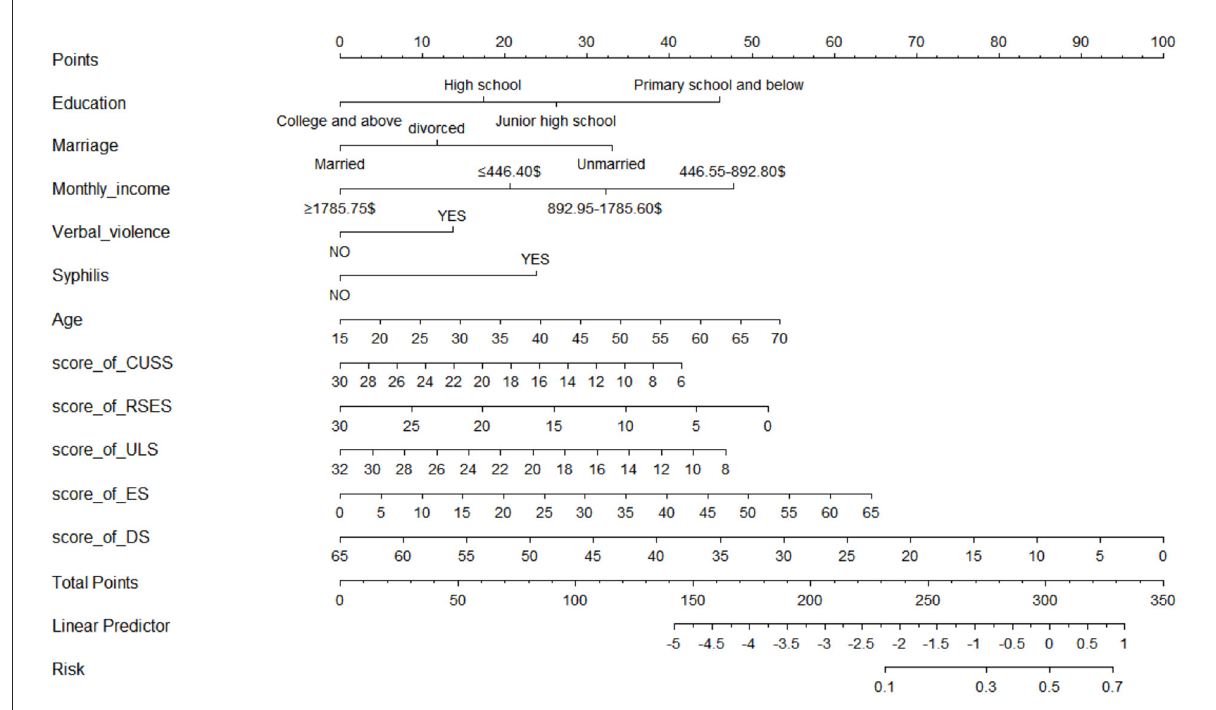
FIGURE1 The nomogram for predicting HIV infection among internal migrant MSM.